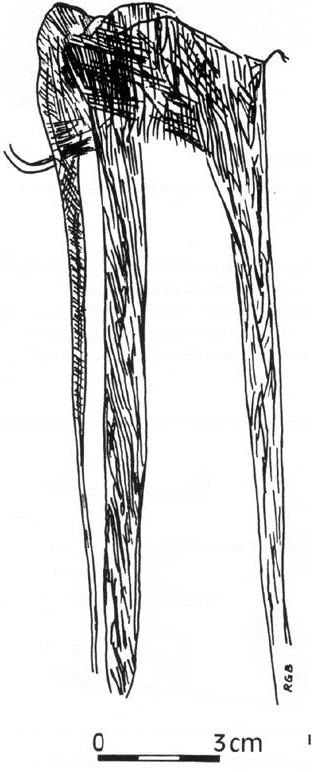
Figure 8. Presumed mammoth engraving on a mammoth tusk from Berelekh, Indigirka river in far-northern